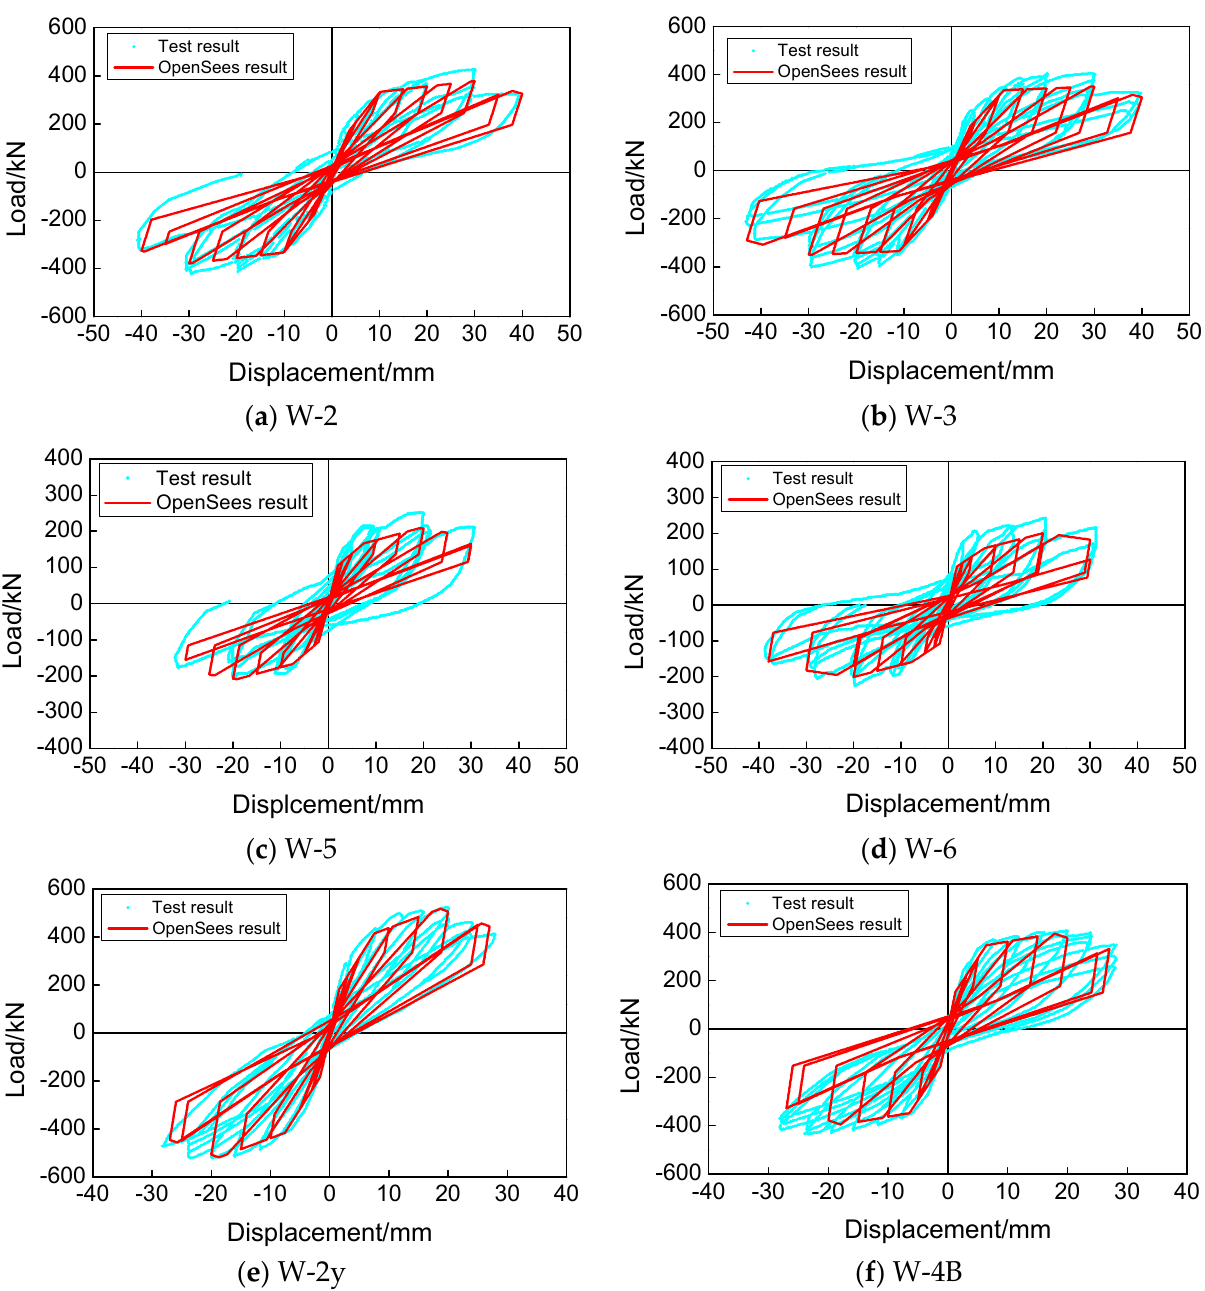
Figure 8. Comparison of the test results and the calculated results of hysteretic curves.